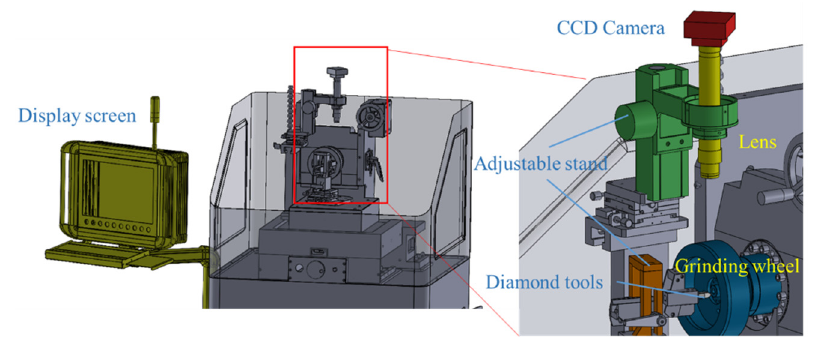
Figure 8. 3D model of the experiment platform.